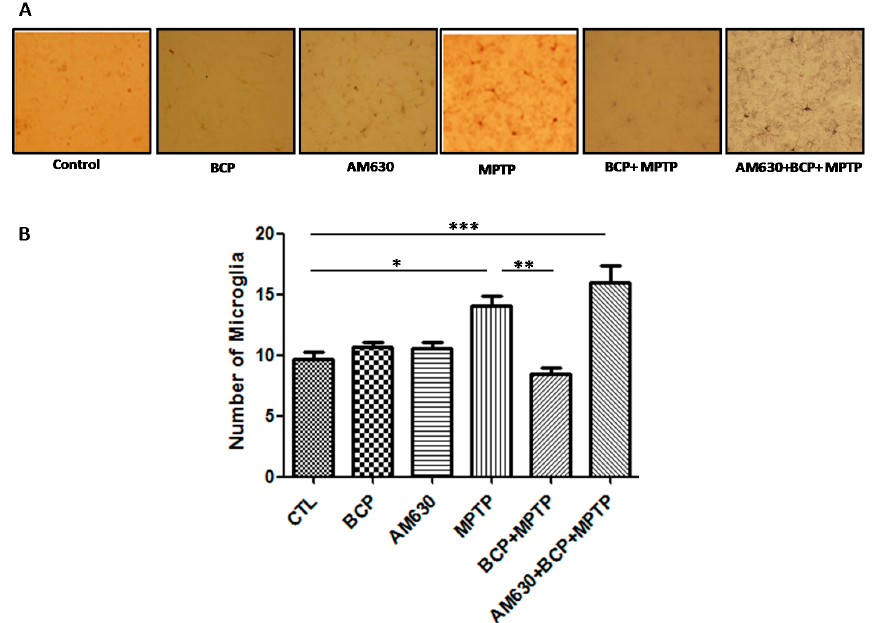
Figure 7. Effect of BCP on MPTP-induced microglia activation in the mouse SNpc. ( A ) Ionized calcium-binding adapter molecule-1 (IBA-1)-IR microglia in mouse SNpc. Scale bar: 200 μ m. ( B ) Stereological cell counts of IBA-1-IR microglia. The data are presented as the mean ± SEM of six individual experiments. * p < 0.05, CTL vs. MPTP treatment. ** p < 0.01, MPTP vs. BCP + MPTP treatment. *** p < 0.001, CTL vs. AM630 + BCP + MPTP treatment.